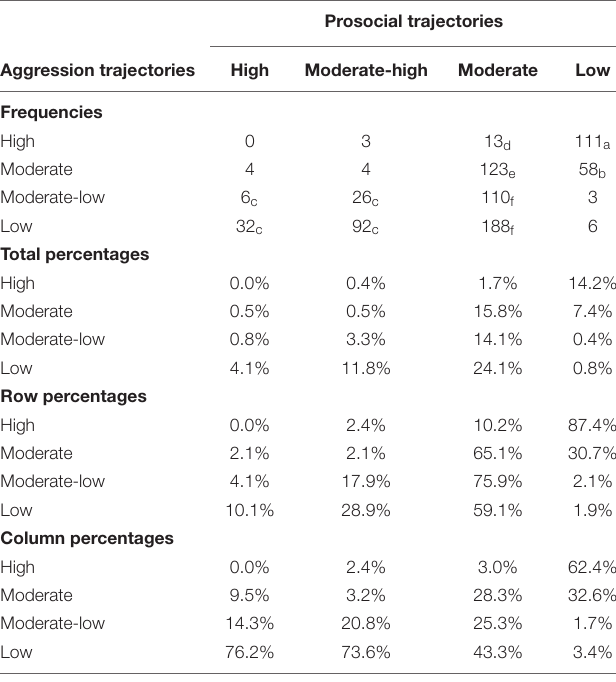
TABLE 3 | Cross-tabulations examining the frequencies and percentages of children’s co-occurring aggression and prosocial trajectory classes.